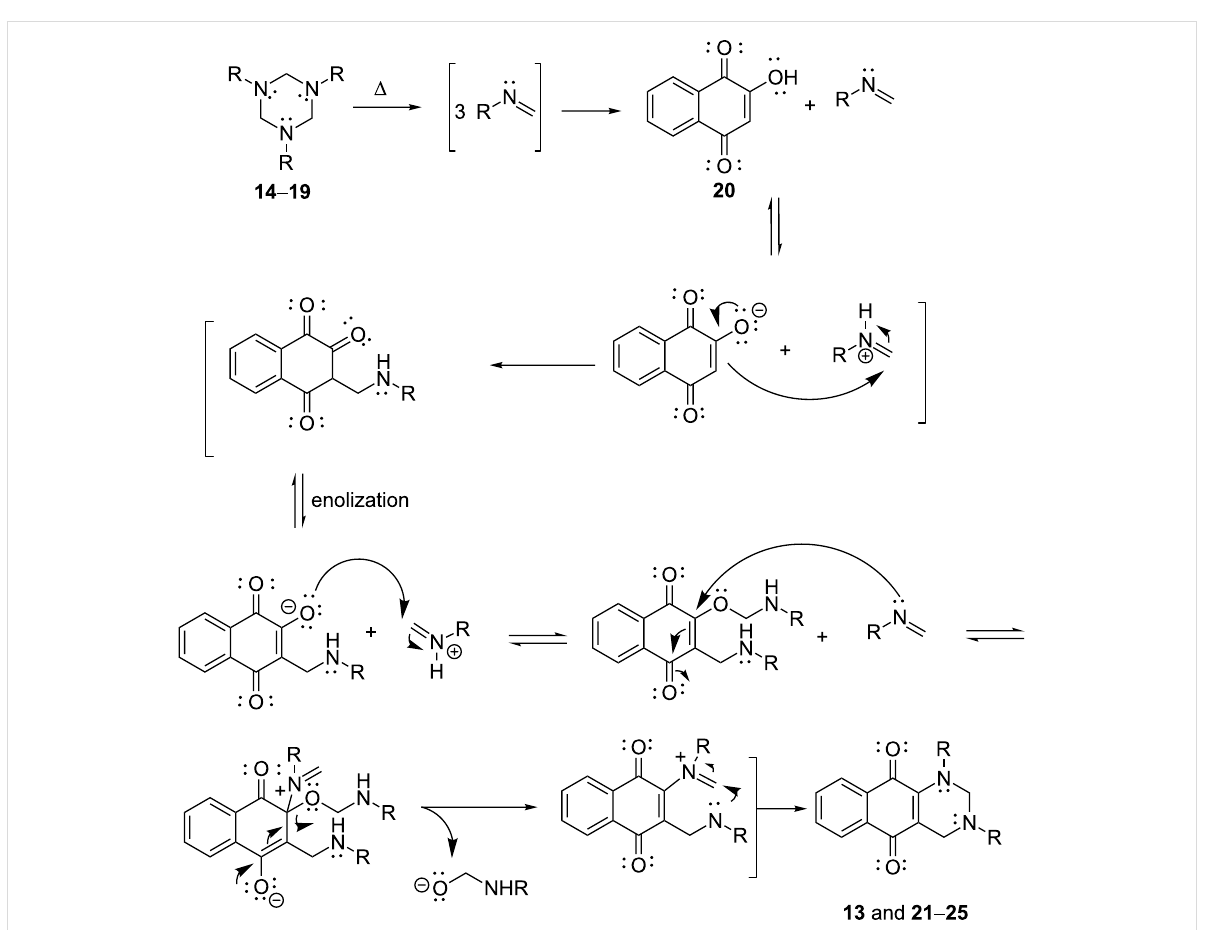
Scheme 3: Proposed mechanism for the formation of 13 and 21–25 .